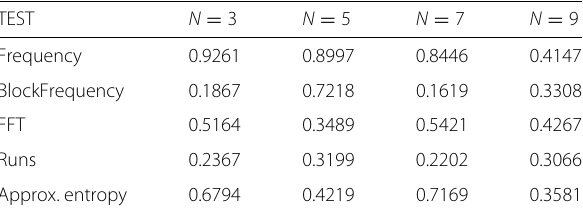
Table 4 NIST statistical test suite results ( p value >